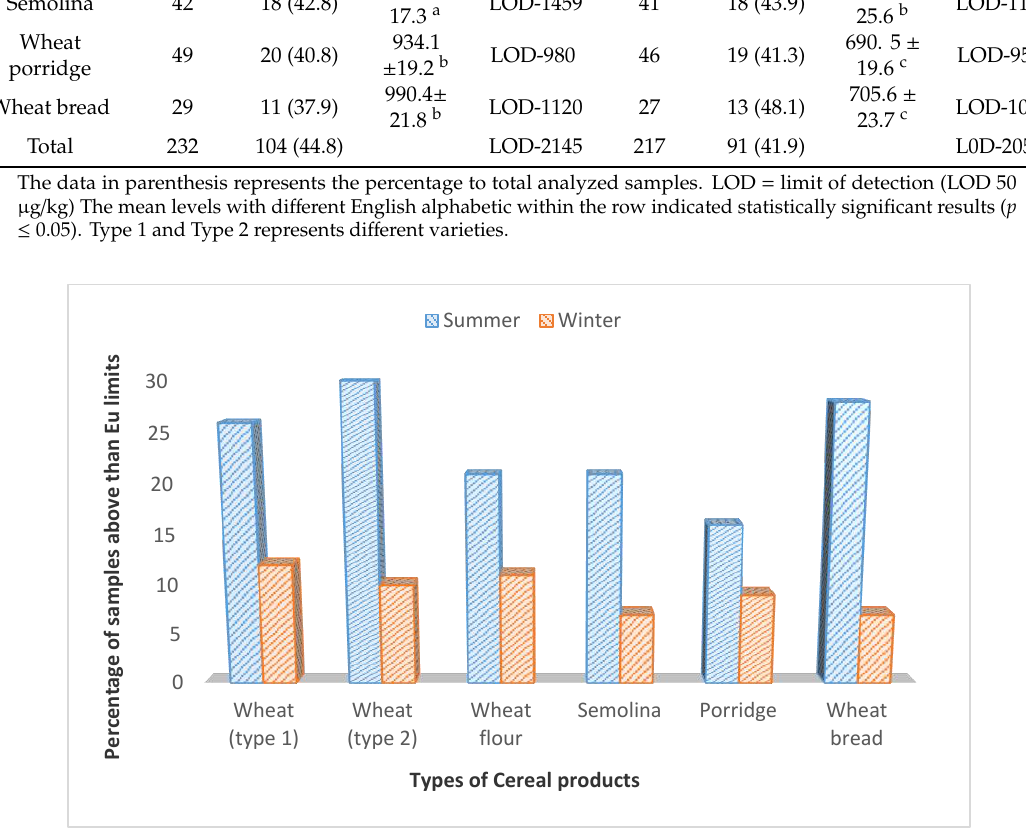
Figure 1. Comparision of sample of wheat and products having levels of DON higher than EU limits.